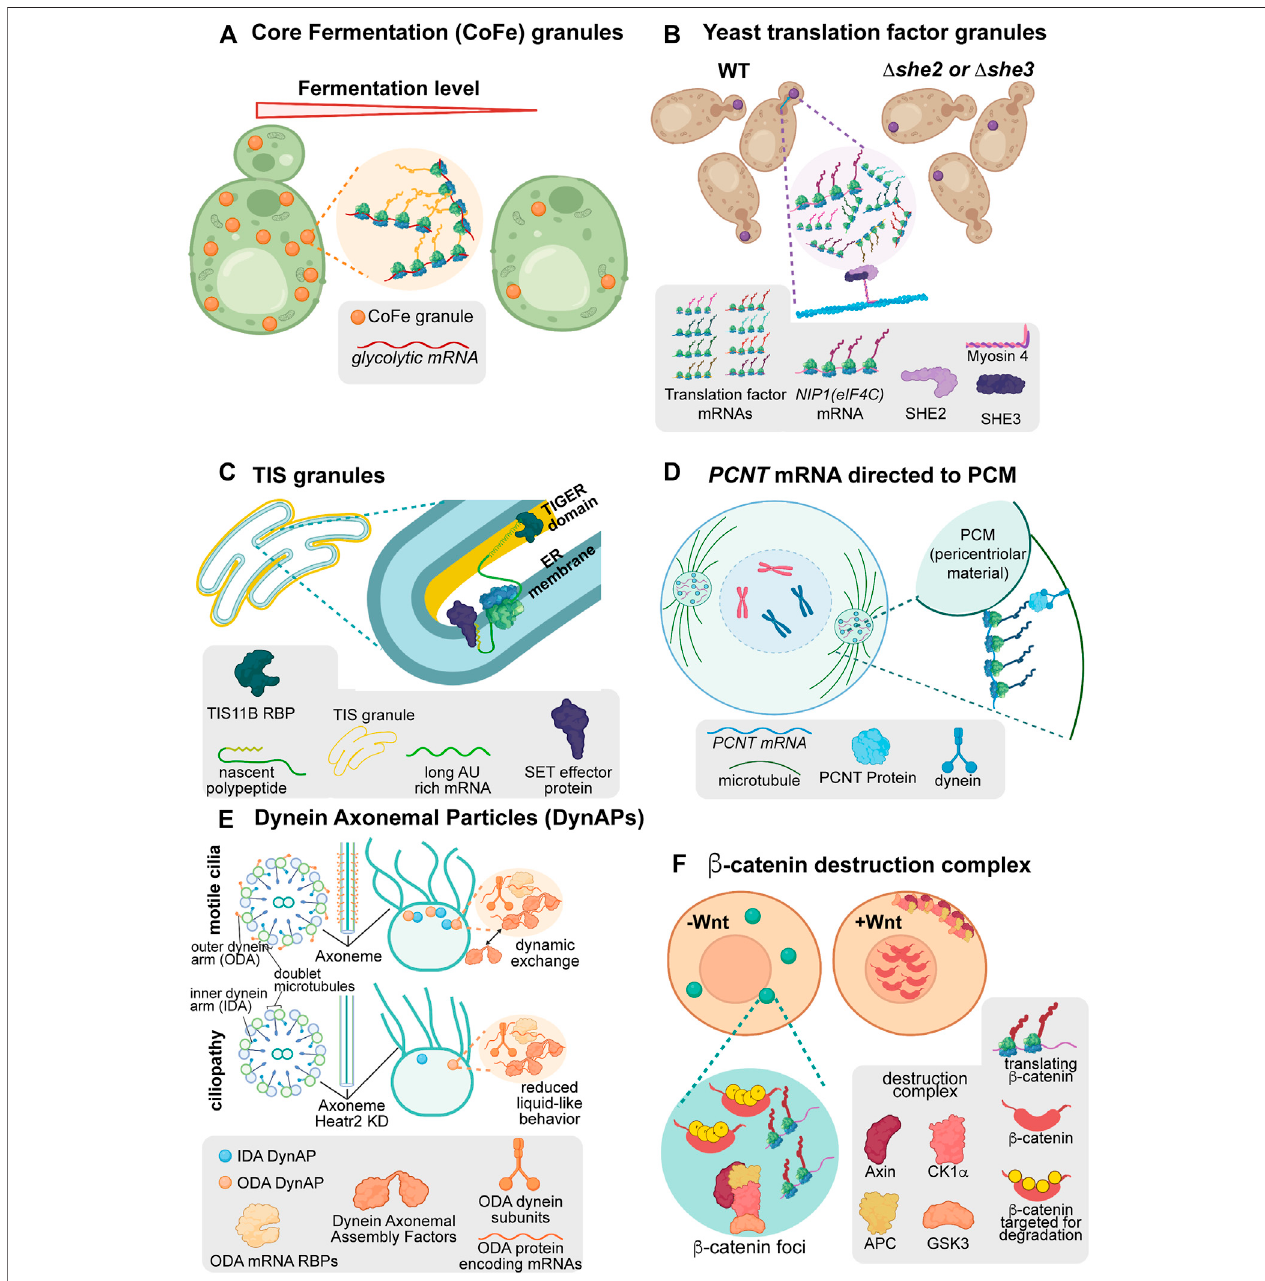
FIGURE 3 | Condensates are associated with diverse forms of post-transcriptional regulation. (A) Saccharomyces cerevisiae translation factor granules are polarizedtranslationfactorycondensatesassociatedwithtranslationatregionsofgrowth.Whenthe SHE2 or SHE3 genesareremovedfromcells,thesecondensatesno longer polarize in lab or wild isolate strains. (B) Core Fermentation (CoFe) granules in S. cerevisiae are translation factory condensates associated with the translation of glycolytic components under fermentative conditions. (C) TIS granules in human cell lines are mesh-like condensates interweaved with the ER. In these condensates, TIS11B associates withAUrich elements present inthelong3 ′ UTRisoformof CD47 tofacilitateinteraction withits effectorprotein,SET,upontranslation. This condensate-associated interaction promotes increased association of CD47 protein with the cell membrane. (D) In human cells, the PCNT RNA is actively transported towards the centromere while translating to facilitate rapid incorporation into transient pericentriolar condensates. These condensates support the organization of the pericentriolar material and microtubules to allow mitosis to occur normally. (E) Dynein axonemal particles (DynAPs) spatially organize dynein proteins within a condensate environment to promote their appropriate assembly in a “ reaction crucible ” mechanism. When the condensate environment is disrupted through depletion of Heatr2, Dynein complex assembly is disrupted, axonemal Dynein organization is perturbed, and cilial beating is decreased. (F) The ß-catenin destruction complex is a condensate which forms throughout the cell cycle to degrade the constitutively translated ß-catenin protein. Upon induction of Wnt signaling, the components of the destruction complex are modi fi ed causing the complex to disassemble and become sequestered at the plasma membrane. When the destruction complex is sequestered, nascent ß-catenin protein can translocate to the nucleus to perform its functions in Wnt signaling.